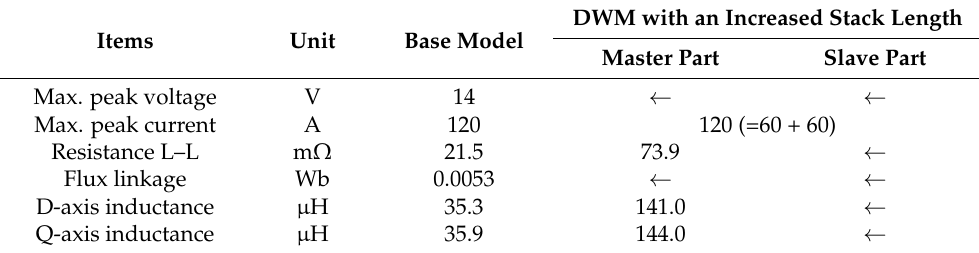
Table 3. Comparison of motor control parameters between base model and DWM with an increased stack